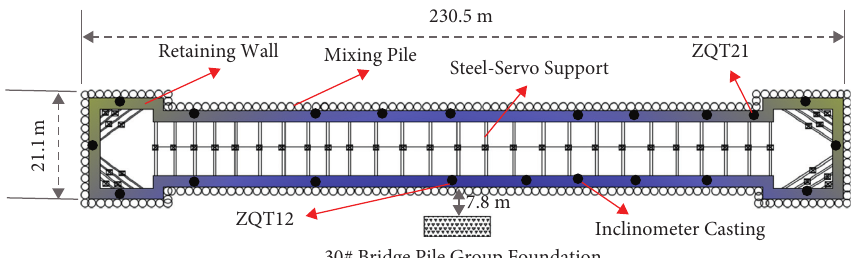
Figure 16: Shenzhen Line 12 subway station excavation pit profile showing the plan view and inclinometer castings for monitoring purpose.